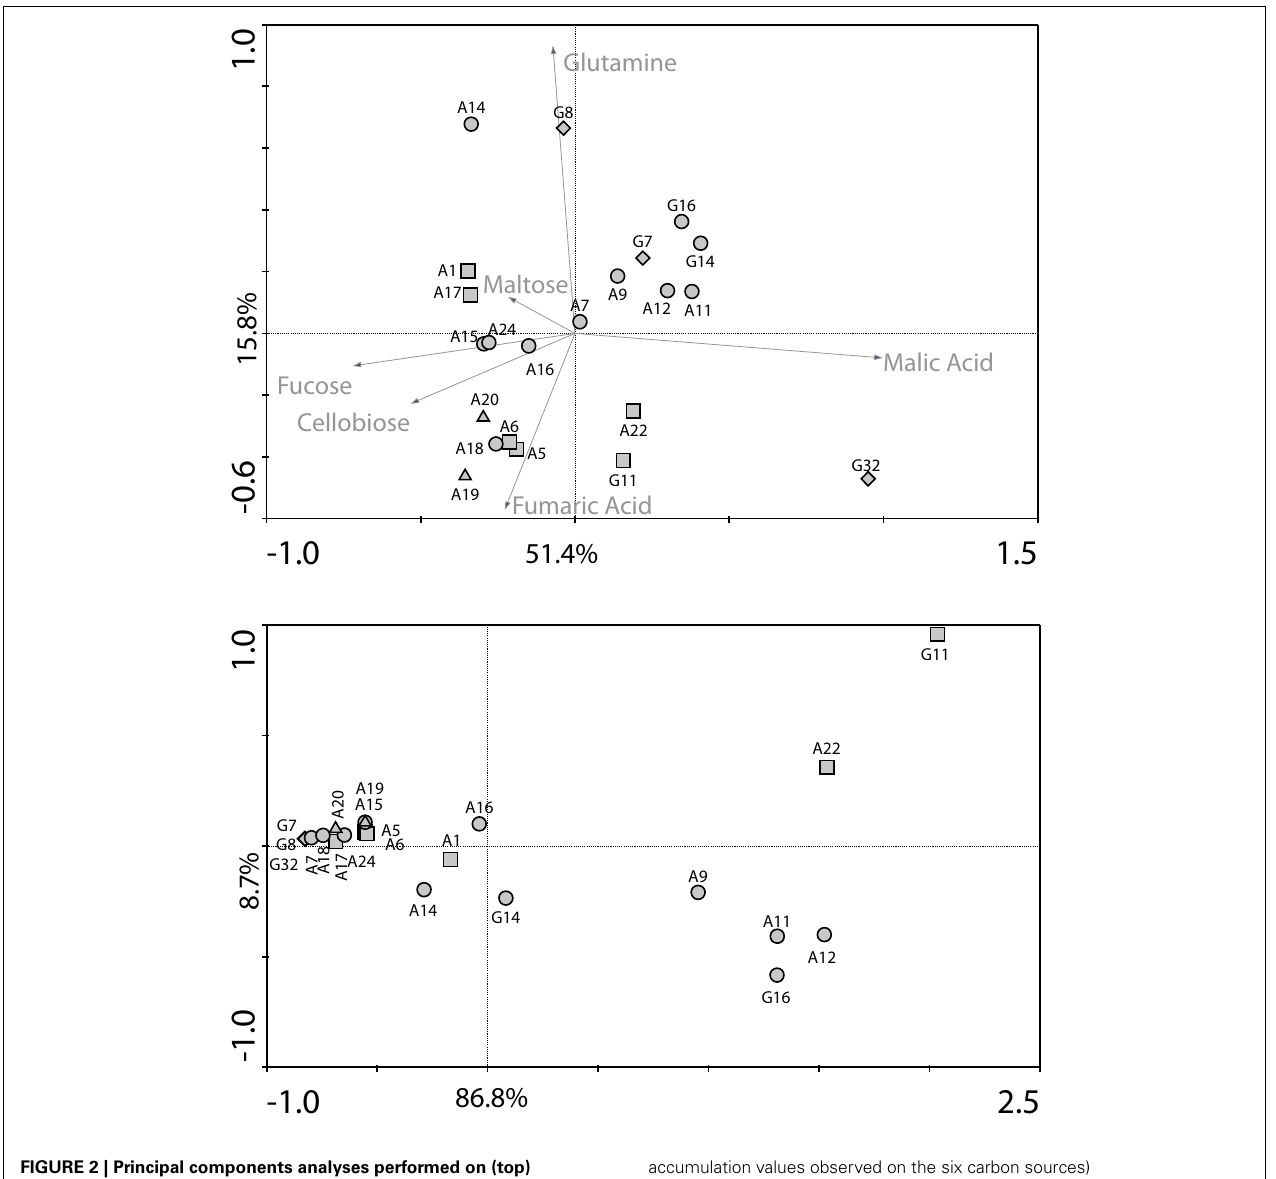
FIGURE 2 | Principal components analyses performed on (top) normalized and (bottom) non-normalized N 2 O accumulation values ( μ gN-N 2 O ml culture − 1 ) obtained for each strain on each carbon source, 66h after the inoculation. Normalized data (for each strain, each accumulation value is divided by the sum of